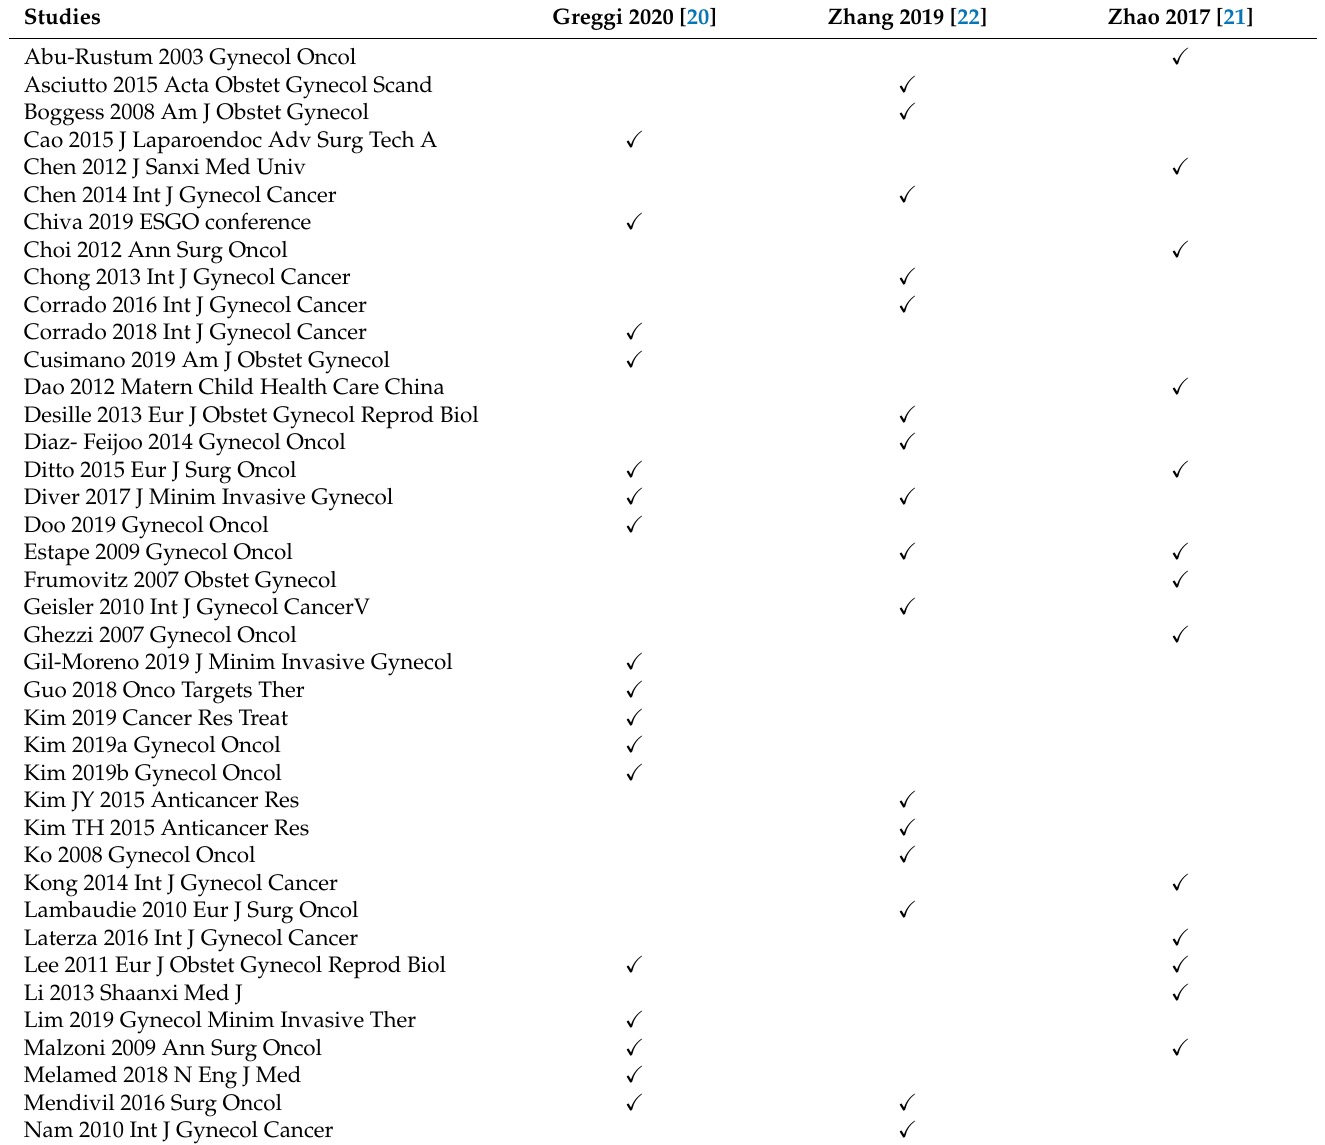
Table A1. Primary studies included in the